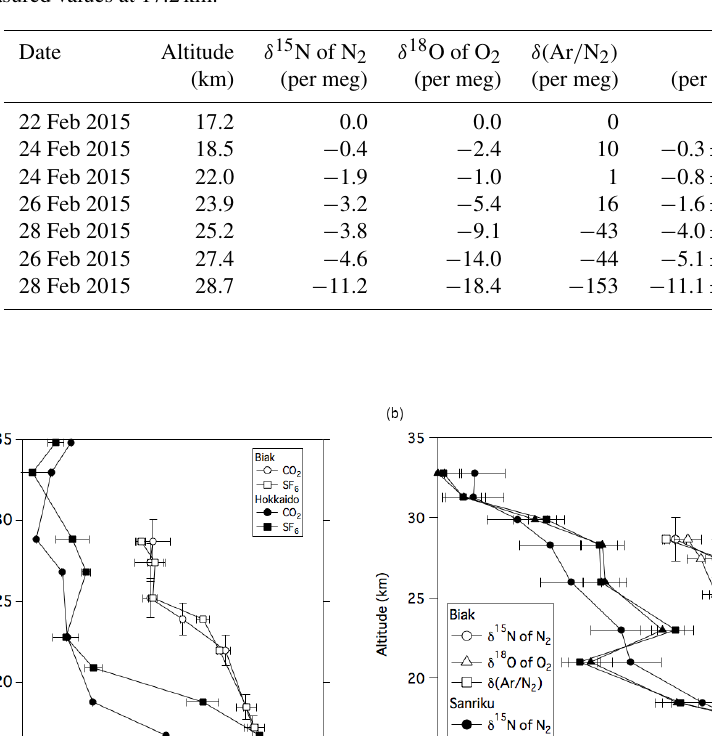
Table 2. The values of δ 15 N of N 2 , δ 18 O of O 2 , δ (Ar / N 2 ) , and < δ > observed over Biak, Indonesia in February 2015. All values are expressed as deviations from the measured values at 17.2km.